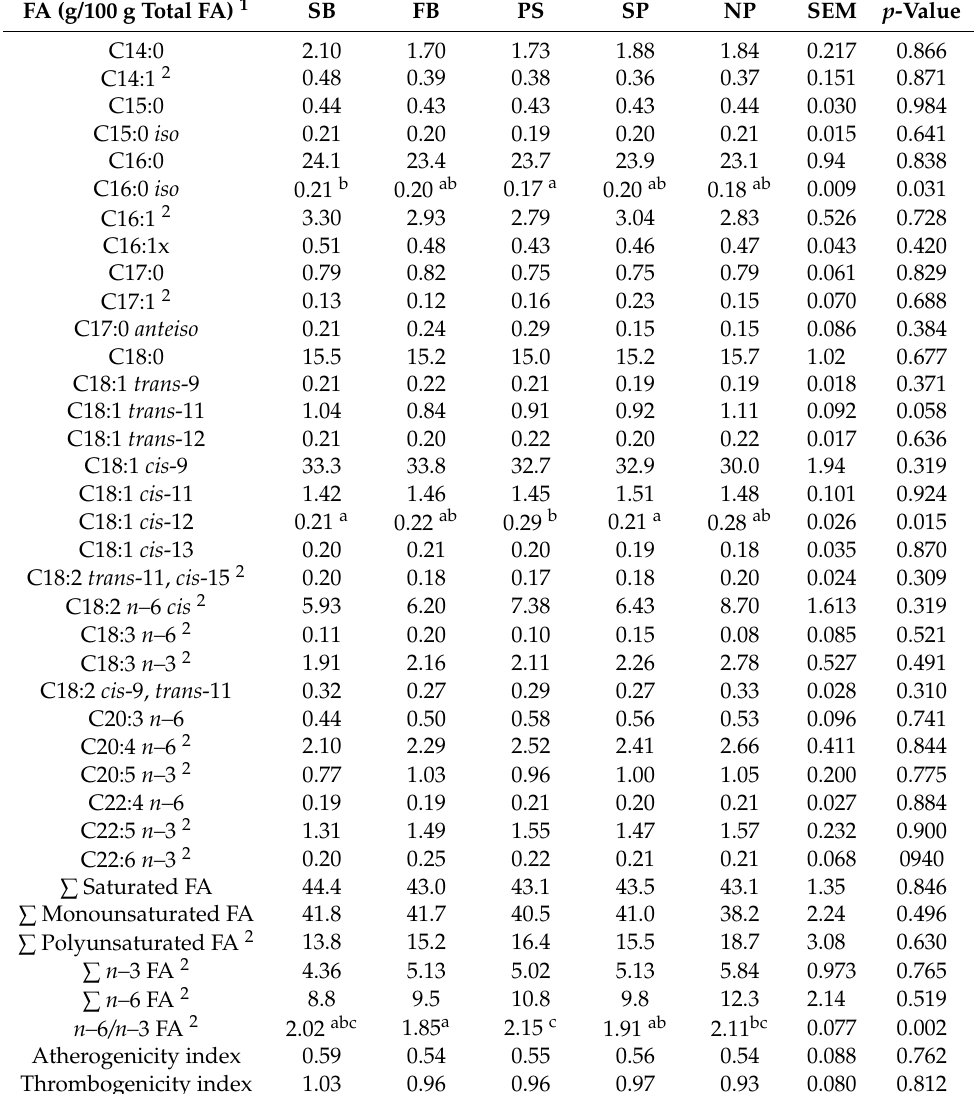
Table 6. Fatty acid (FA) profile of the longissimus thoracis et lumborum of fattening bulls fed a grass/maize-silage based diet complemented with concentrates containing soybean meal (SB), faba beans (FB), pumpkin seed cake (PS), spirulina (SP), or no additional protein source (NP), ( n = 6 per